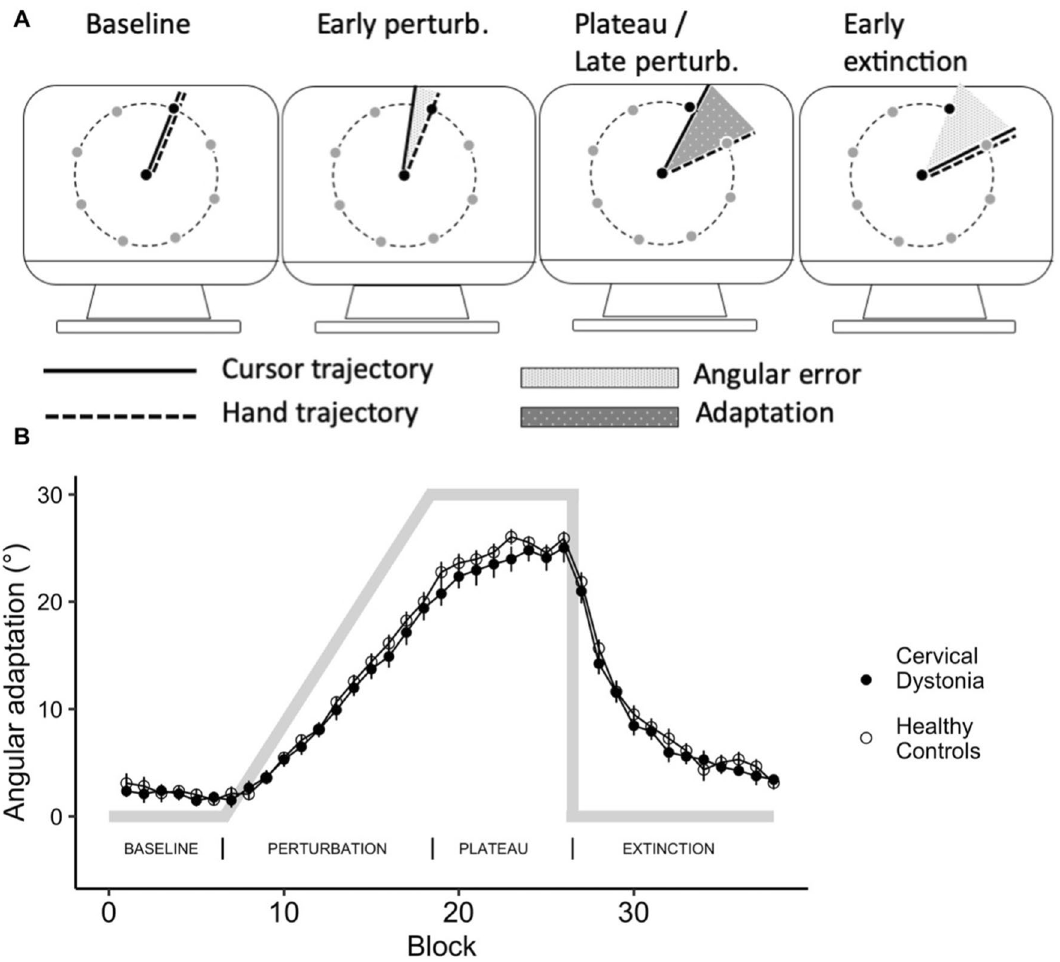
Figure 2. Motor adaptation. ( A ) Schematic course of the experiment indicating difference between visible movements of the cursor on screen and invisible movement of the hand on the digitizing tablet. ( B ) Adaptation to a gradually introduced visuomotor perturbation did not differ between cervical dystonia patients and healthy controls. Points represent adaptation (mean ± SE of eight consecutive trials), grey lines indicate the applied